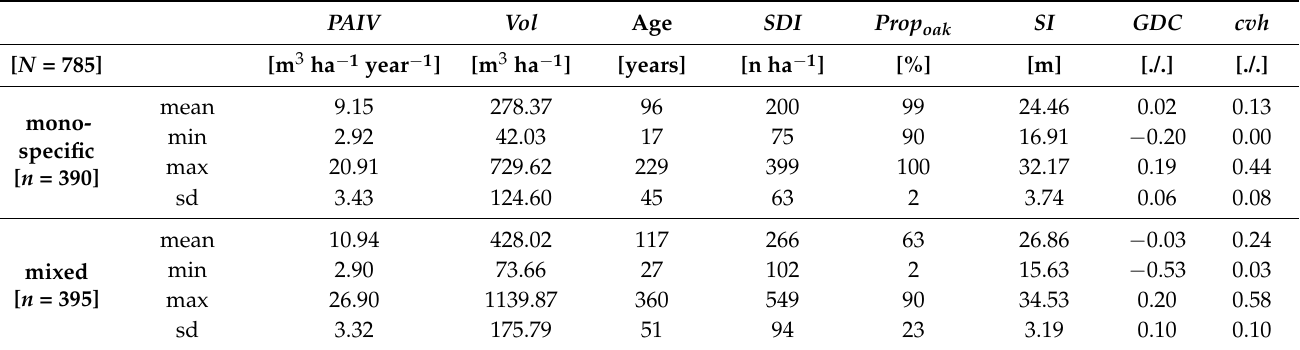
Table 2. Stand data; PAIV —periodic annual increment; Vol —standing volume; Age—stand age; SDI —stand density index; Prop oak —proportions of oak; SI —site index; GDC —growth dominance coefficient; cvh - variation coefficient of tree heights; shown are mean, min, max and sd values for monospecific and mixed oak stands; N and n —number of observations.